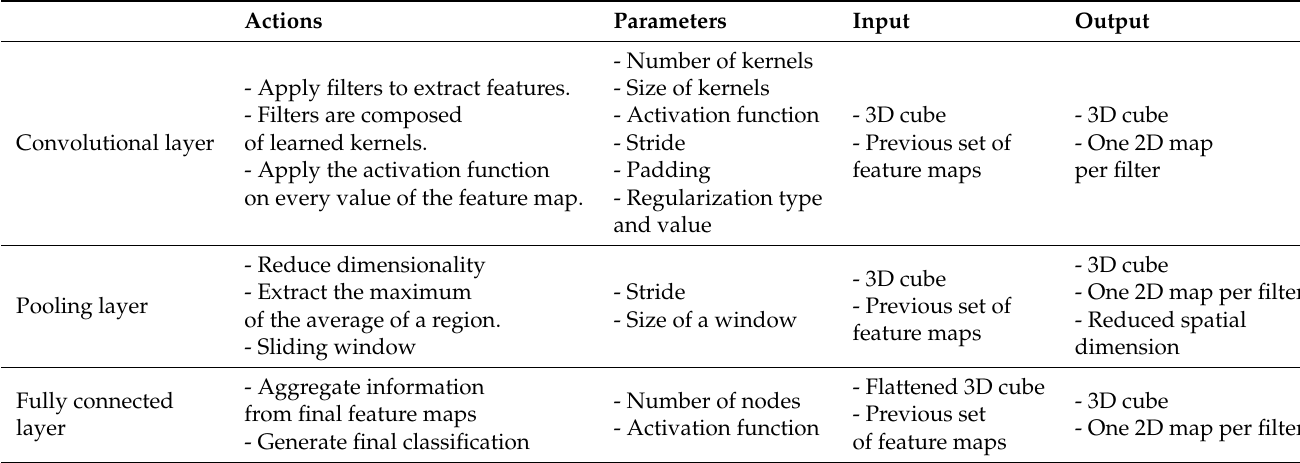
Table 2. Details of the three CNN layers.